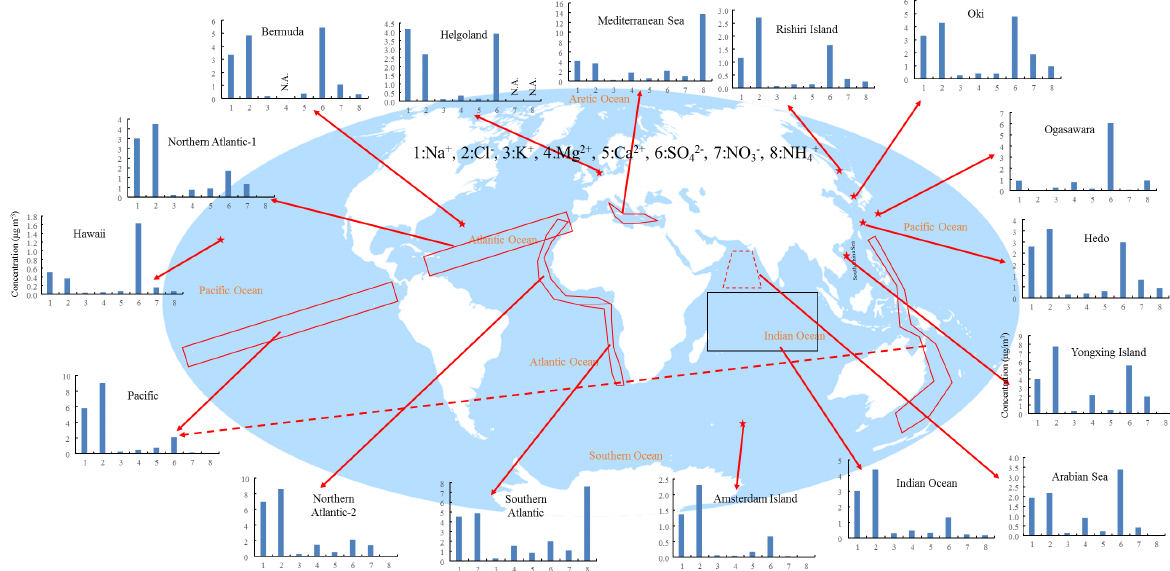
Figure 5. Comparisons of major ions in aerosol at Yongxing Island with global ocean. Data of Oki, Ogasawara and Hedo are from EANET (www.eanet.asia); data of Rishiri Island are from Okuda et al. (2006); data of Hawaii are from Carrillo et al. (2002); data of Bermuda are from Moody et al. (2014); data of Amsterdam Island are from Claeys et al. (2010); data of the Arabian Sea and Indian Ocean are from Kumar et al. (2008); data of Helgoland are from Ebert et al. (2000); and data of the Mediterranean Sea, North Atlantic 1 and 2, Pacific and South Atlantic are from Zhang et al. (2010). Pentagrams represent sampling sites on islands while others represent cruises. N.A. indicates no data.